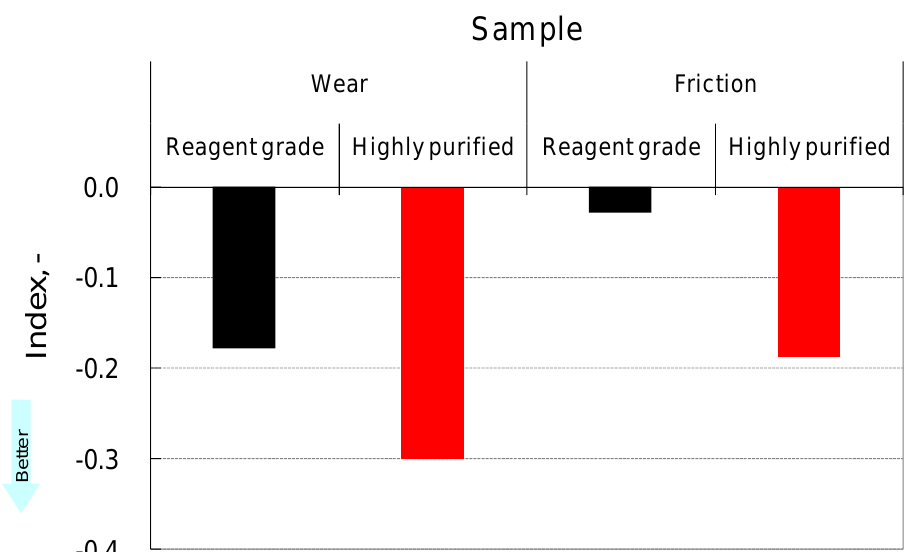
Figure 7. Influence of purity on additive response. (See nomenclature for